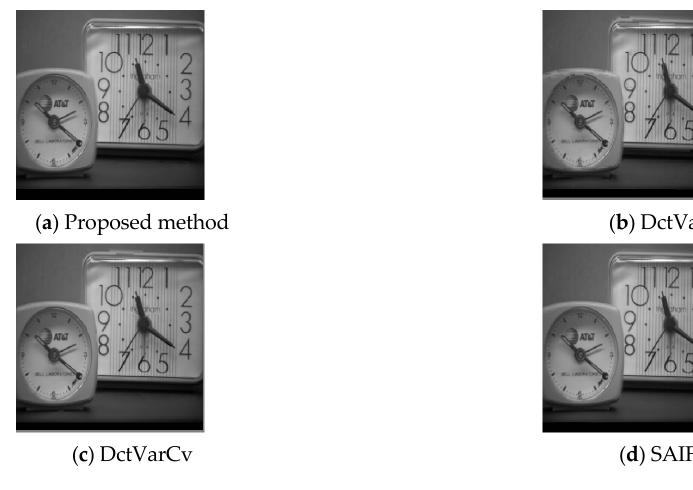
Figure 10. The fusion result of the clock image.